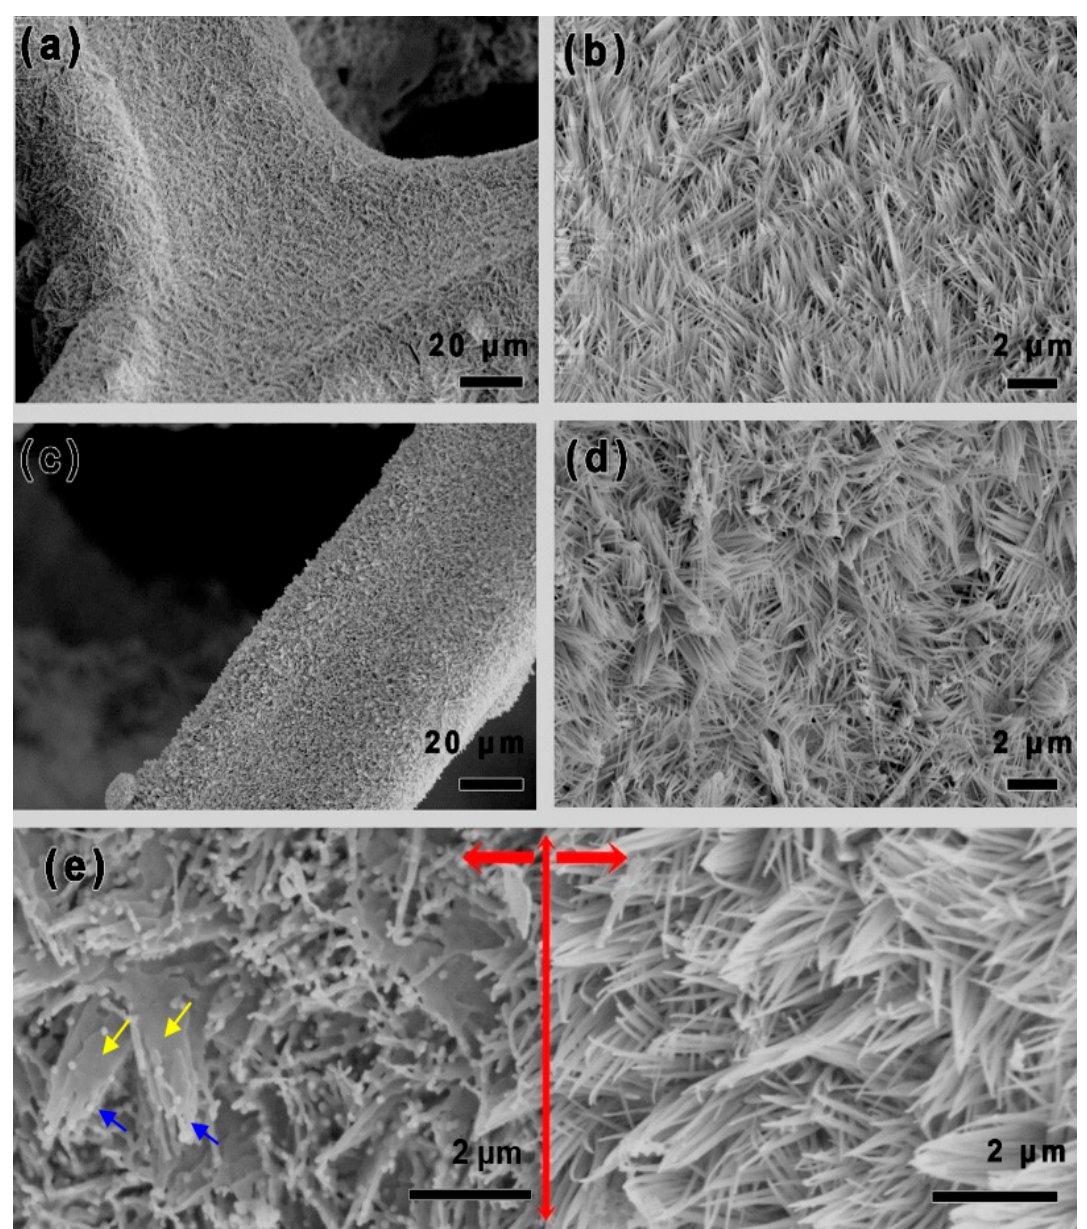
Figure 3. SEM images of ( a , b ) Ni-Co oxide, ( c , d ) Ni-Co sulfide, and ( e ) the Ni-Co sulfide partially treated by focus ion beam irradiation.